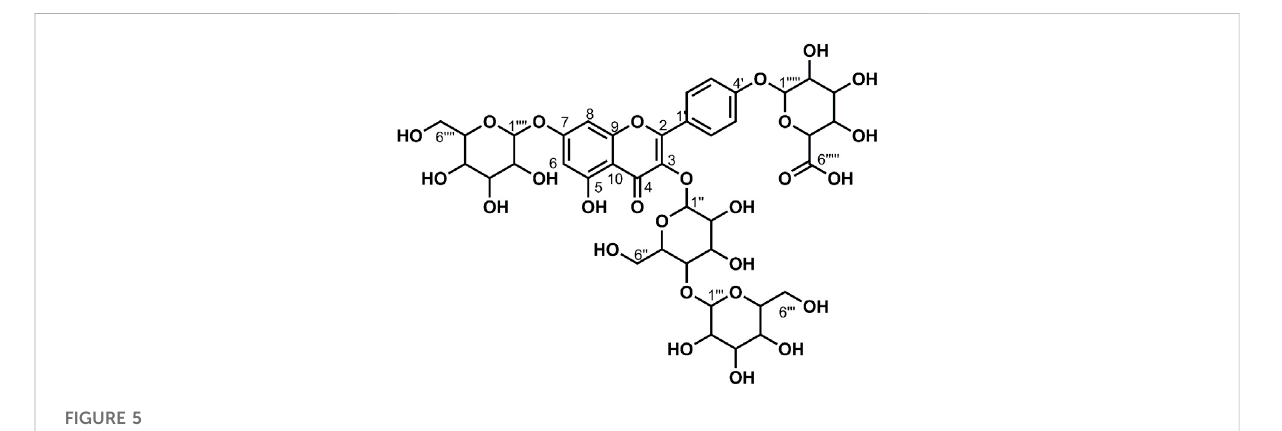
FIGURE 5 Chemical structure of compound 9 .